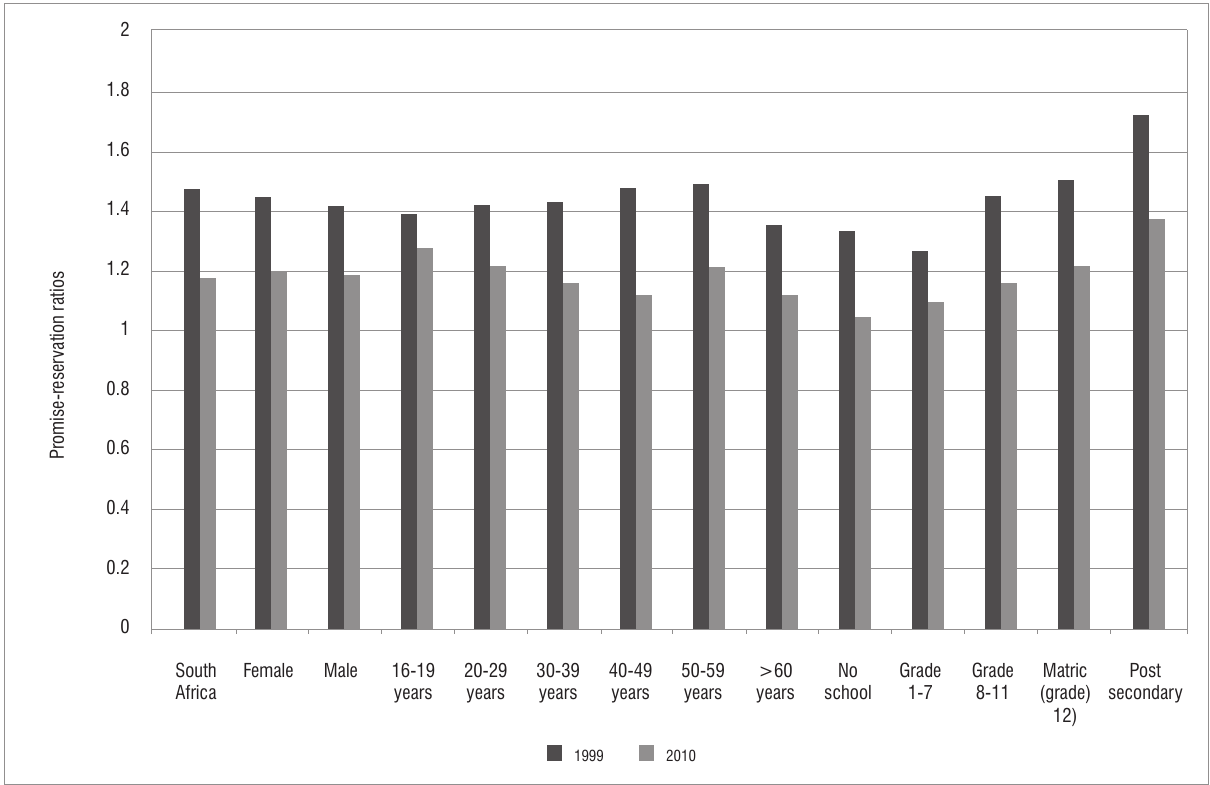
Figure 3: Promise-reservation ratio by gender, age and educational level for 1999 and 2010.